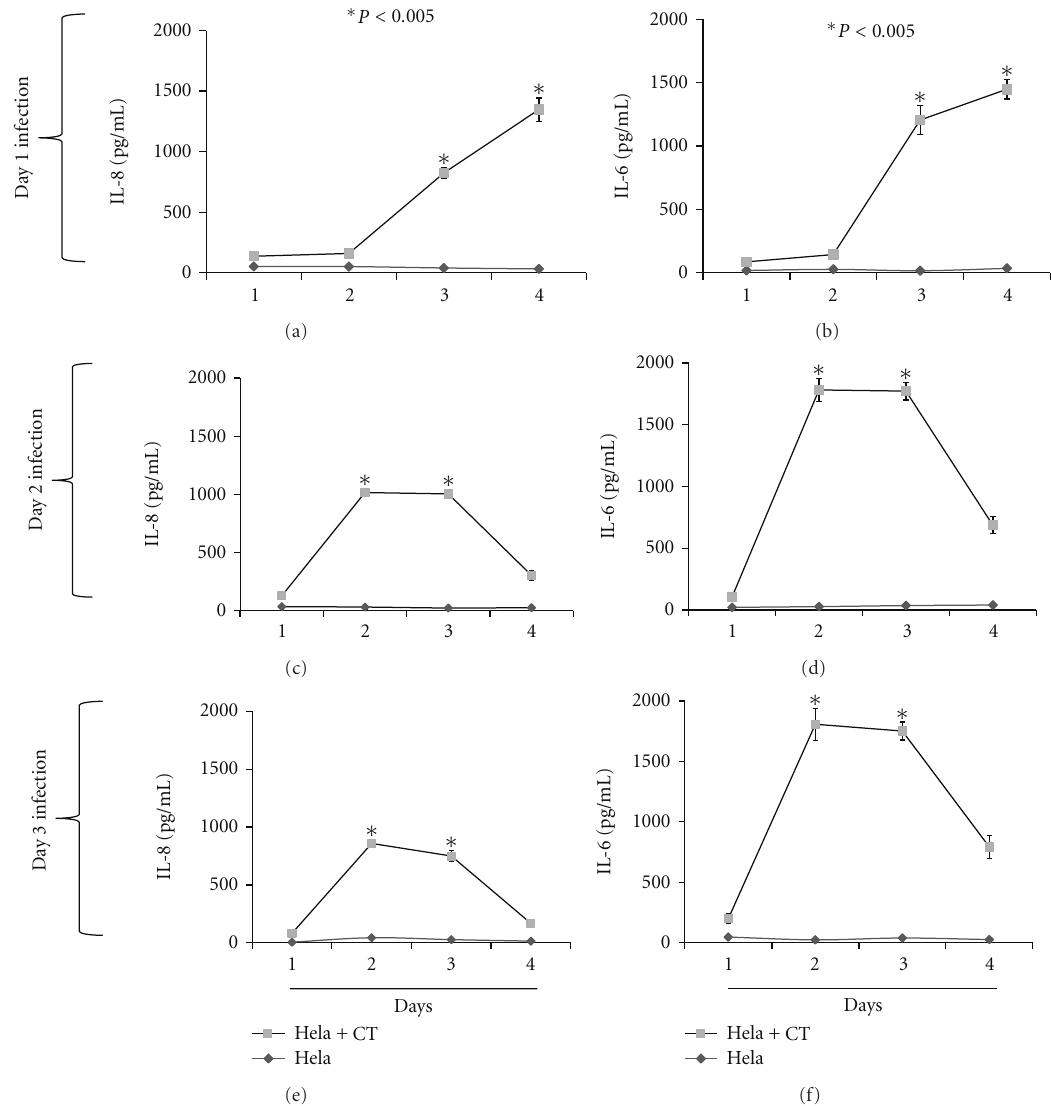
Figure 3: Expression profiles of IL-8 and IL-6 produced in C. trachomatis- (CT-) infected HeLa cells noncumulative supernatants. HeLa cells (10 5 cells/mL/well) were seeded in 24-well plates. Twenty-four hours later cells were infected with C. trachomatis EBs (10 4 IFU/well) and after day 1 (a and b), day 2 (c and d), and day 3 (e and f) infection, cell-free culture supernatants were collected daily and replaced with fresh media (noncumulative). Human IL-8 and IL-6 cytokines were measured using cytokine-specific ELISA. Asterisk indicates significant di ff erence ( P < 0 . 005), and P values were calculated by use of Student’s t- test. Each bar represents the mean ± SD of samples run in triplicates. The data are representative of two separate